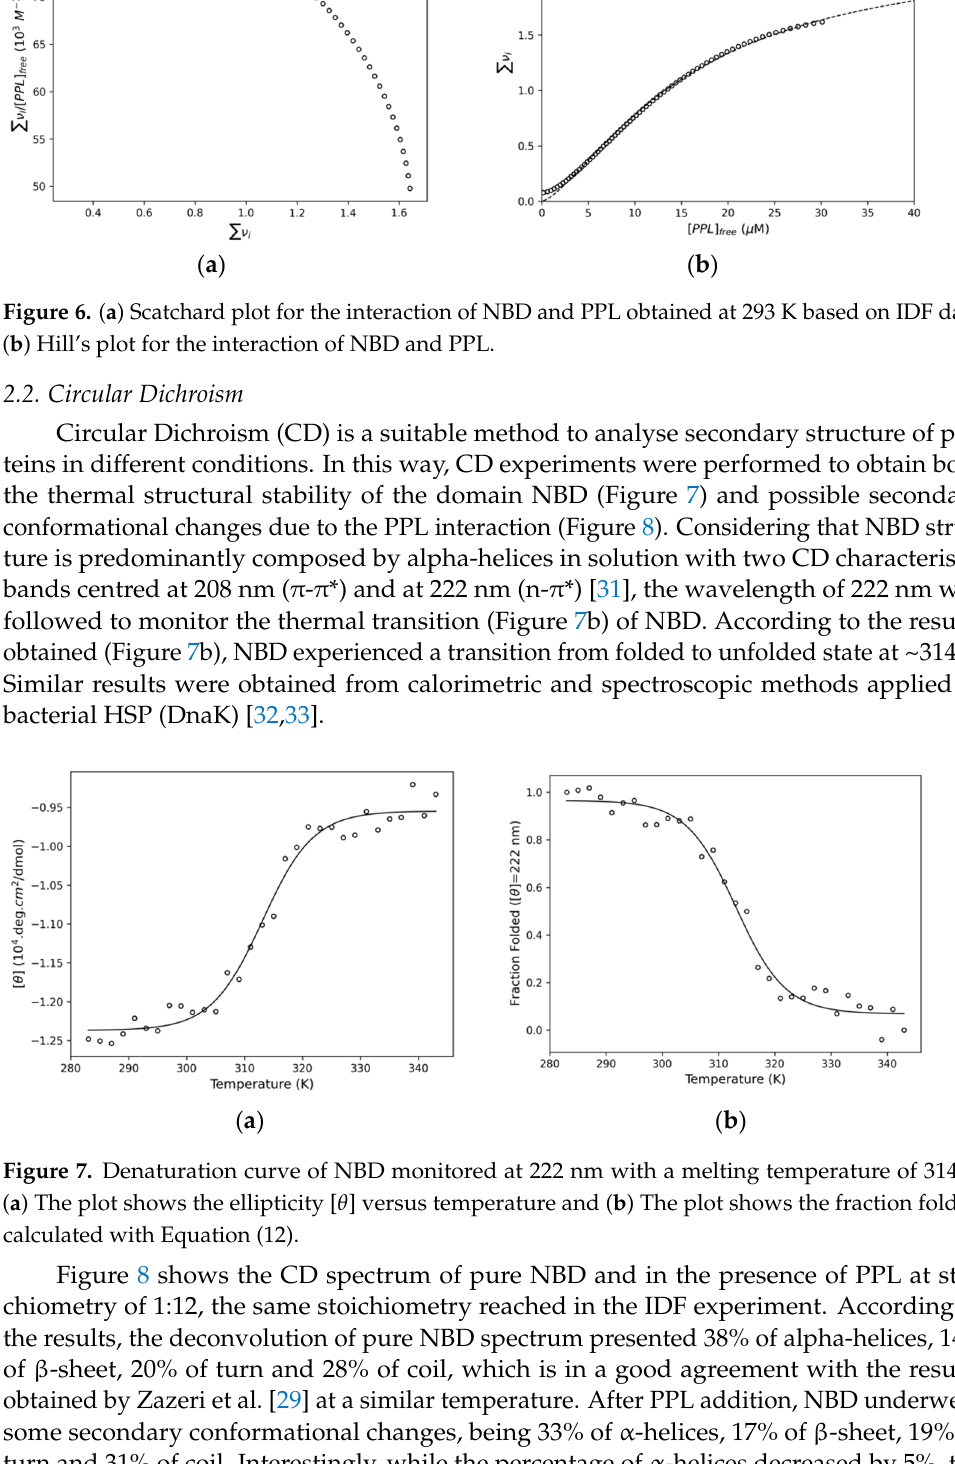
Figure 8. Circular Dichroism of free NBD (solid lines) and NBD + PPL at the stoichiometry 1:12 (dotted lines) at 293 K. 2.3. Molecular Docking The structure of NBD obtained from PDB 1S3X was directly subjected to molecular docking that disclosed several possible pockets where PPL can interact with NBD (Fig- ure S2), with energy ranked from (7.2 to 5.0 kcal). The analysis of the poses from cluster “a” to “g” (Figure S3) revealed that they are in the environment of the binding site ac-